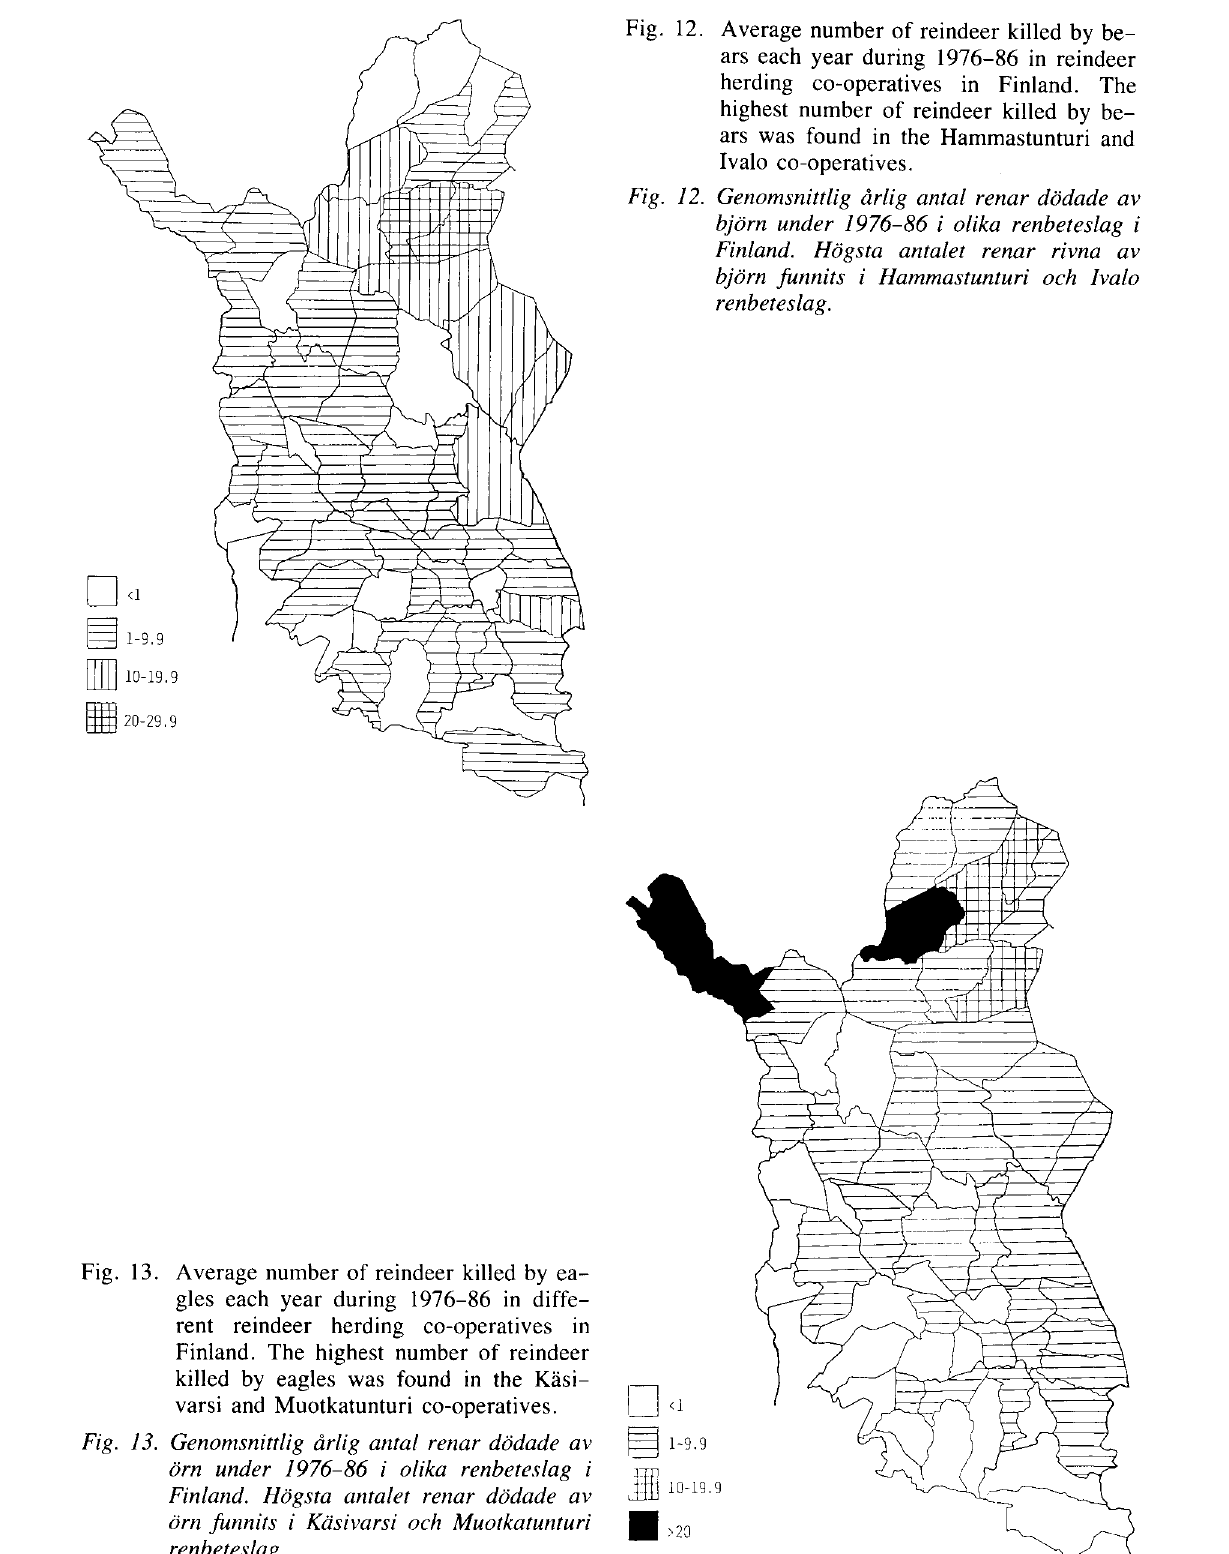
Fig. 13. Average number of reindeer killed by ea gles each year during 1976-86 in diffe rent reindeer herding co-operatives in Finland. The highest number of reindeer killed by eagles was found in the Kåsi- varsi and Muotkatunturi co-operatives. Fig. 13. Genomsnittlig årlig antal renar dodade av orn under 1976-86 i olika renhete slag i Finland. Hogsta antalet renar dodade av orn funnits i Kåsivarsi och Muotkatunturi renbeteslag.